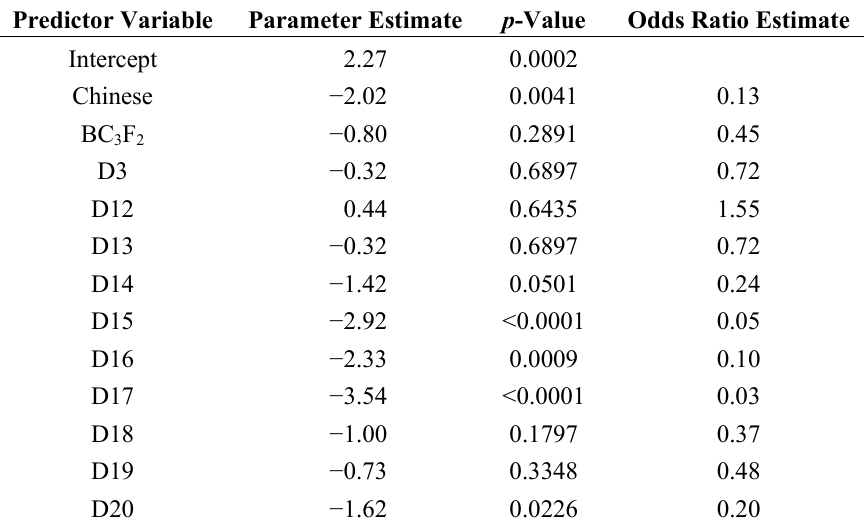
Table 7. Logistic regression model for probability of germination using individually weighed nuts with corresponding seedling measurements. The model is comparing all families to the American